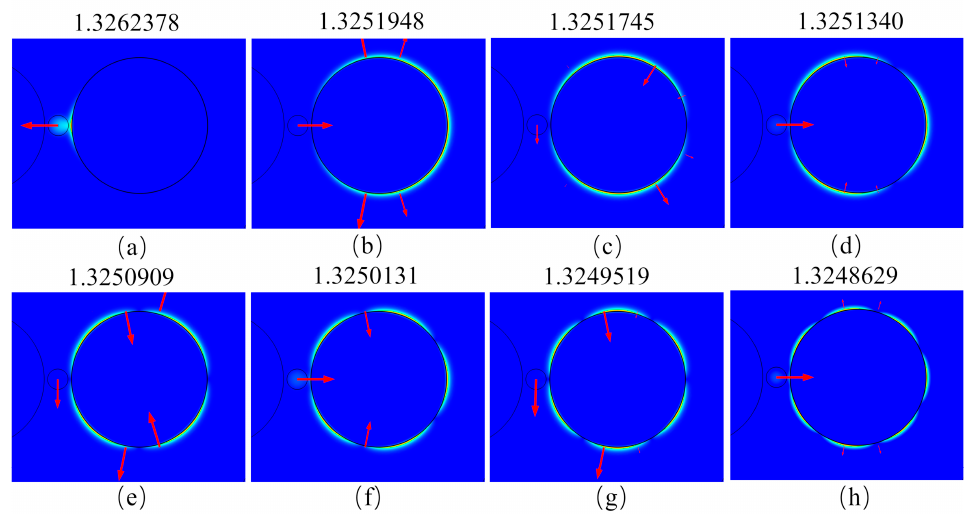
Figure 4. ( a – h ) Electric field distribution and the real part of the effective refractive index Re( n eff ) for low-order surface plasmon polariton (SPP) modes at the wavelength of 1.1 µ m, from the fundamental order ( a ) to the 7th order ( h ) successively. The red arrows are the indicators of the polarization direction. The simulation parameters are the same as in Figure 3.